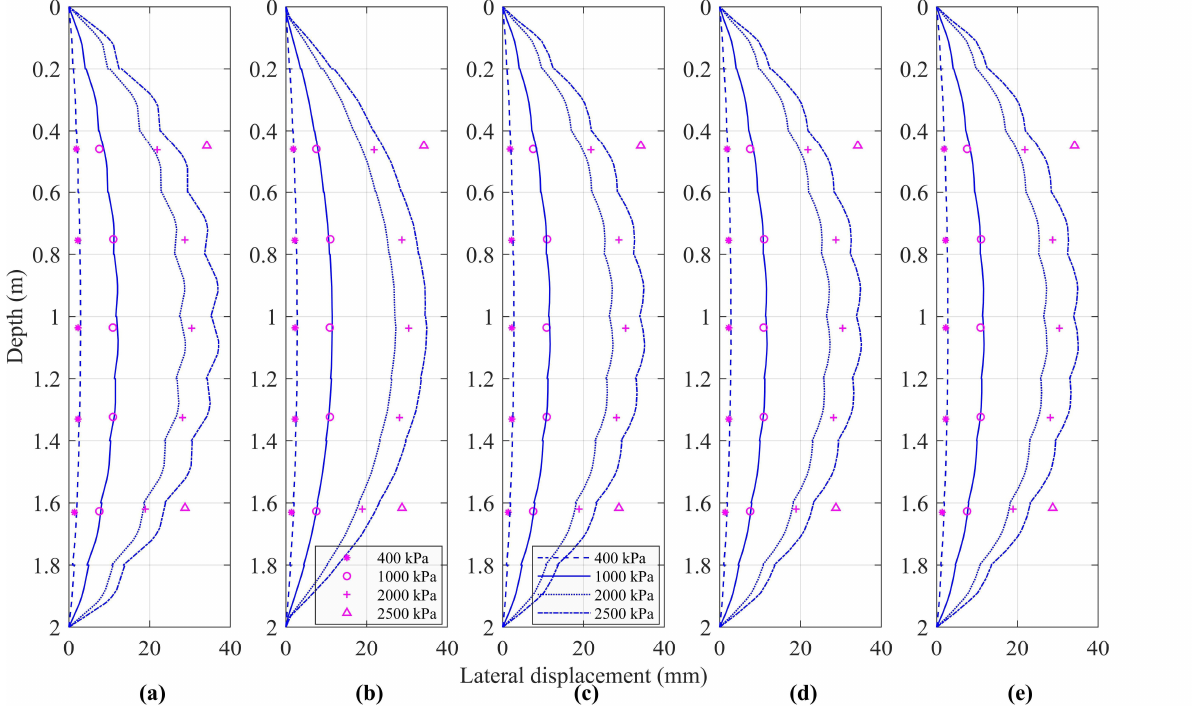
Figure 7. Effect of surcharge load p and compaction procedures on open face lateral displacement of SGC mass, for q = 44 kPa, p = 400, 1000, 2000 and 2500 kPa: ( a ) Type-I; ( b ) Type-II; ( c ) Type-III ( w = 0.7 m); ( d ) Type-III ( w = 0.35 m); ( e ) Type-III ( w = 0.175 m).